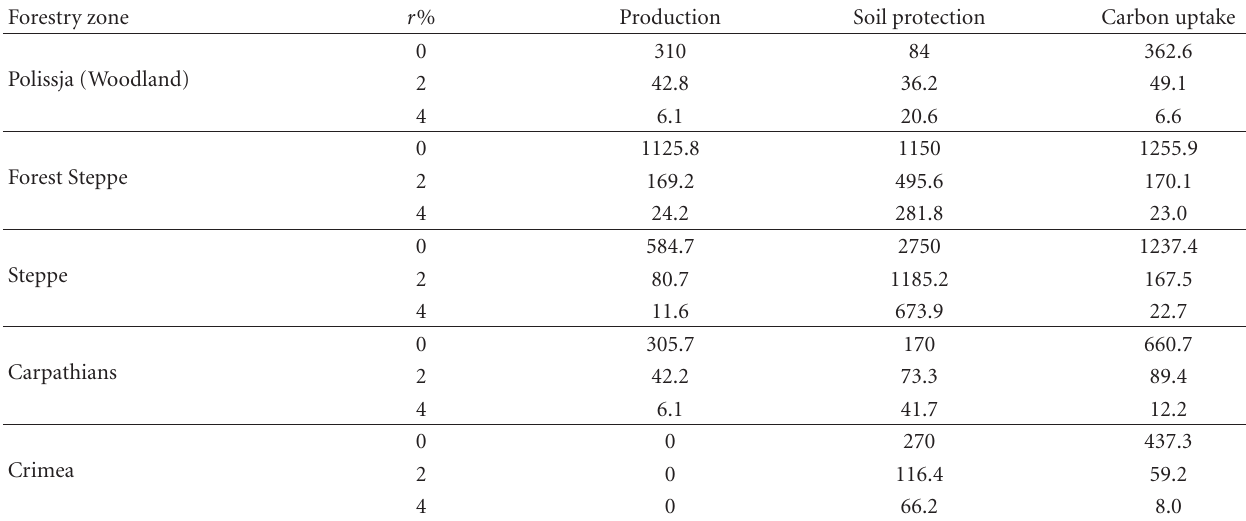
Table 7: A ff orestation benefits, PV MC.